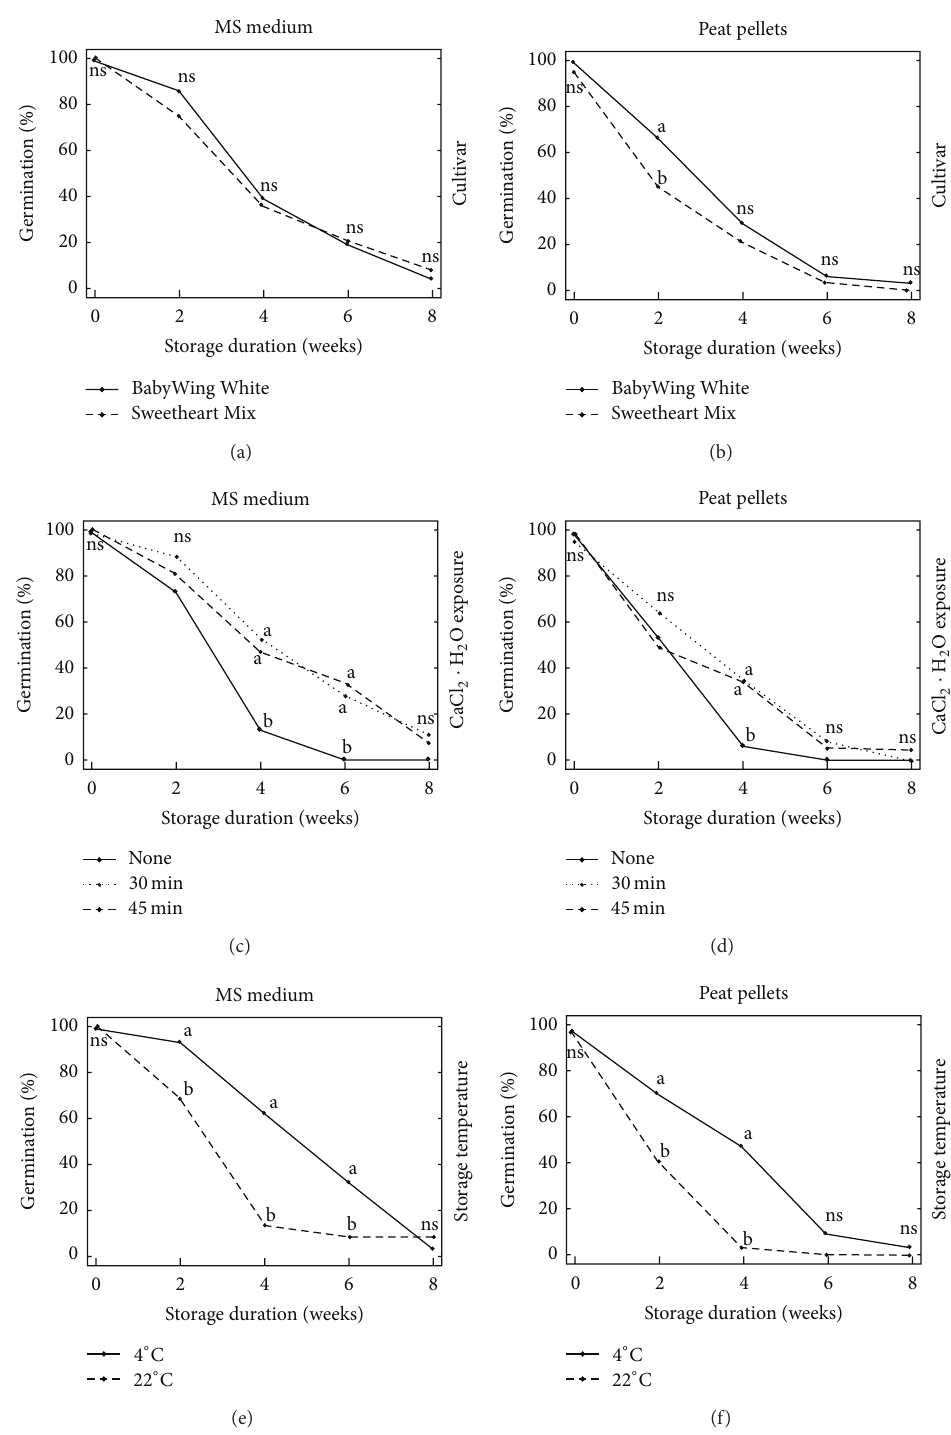
Figure 2: Percentages of encapsulated microshoots (synthetic seeds) and nonencapsulated microshoots of two Begonia cultivars “germinating” (developing successfully) after storage and subsequent transfer to substrate (MS medium ( in vitro ) or peat pellets ( ex vitro )). Encapsulated microshoots were exposed to CaCl 2 ⋅ H 2 O after encapsulation, whereas nonencapsulated microshoots served as a control for this factor. Medium and storage duration were highly influential in significant interaction terms; therefore, analyses of cultivar ((a) and (b)), CaCl 2 ⋅ H 2 O exposure duration ((c) and (d)), and storage temperature ((e) and (f)) were conducted for each combination of medium and storage duration. Cultivar, CaCl 2 ⋅ H 2 O exposure duration, and storage temperature factors showed no significant interactions; therefore, means shown (dots) in each subfigure are averages over the other two factors. Means for a specific storage duration (vertical pairs or trios) within each figure are significantly different ( 𝑃 = 0.05 ) when labeled with “a” and “b,” or not significantly different when labeled with “ns.” The Schaffer-Simulated method was used for multiple mean